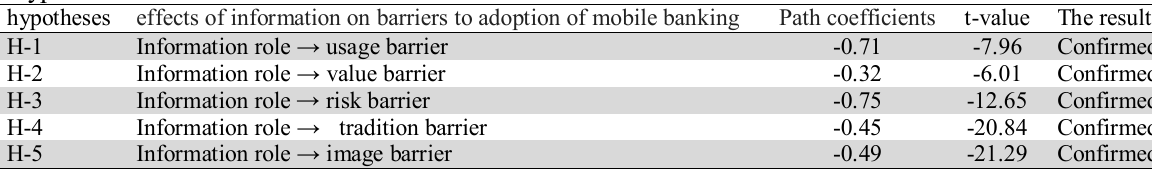
Hypotheses test results